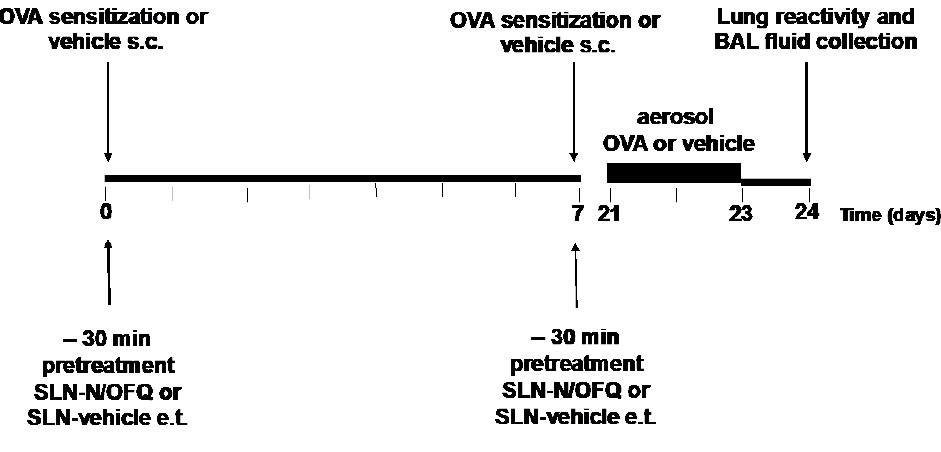
Figure 8. Experimental protocol.